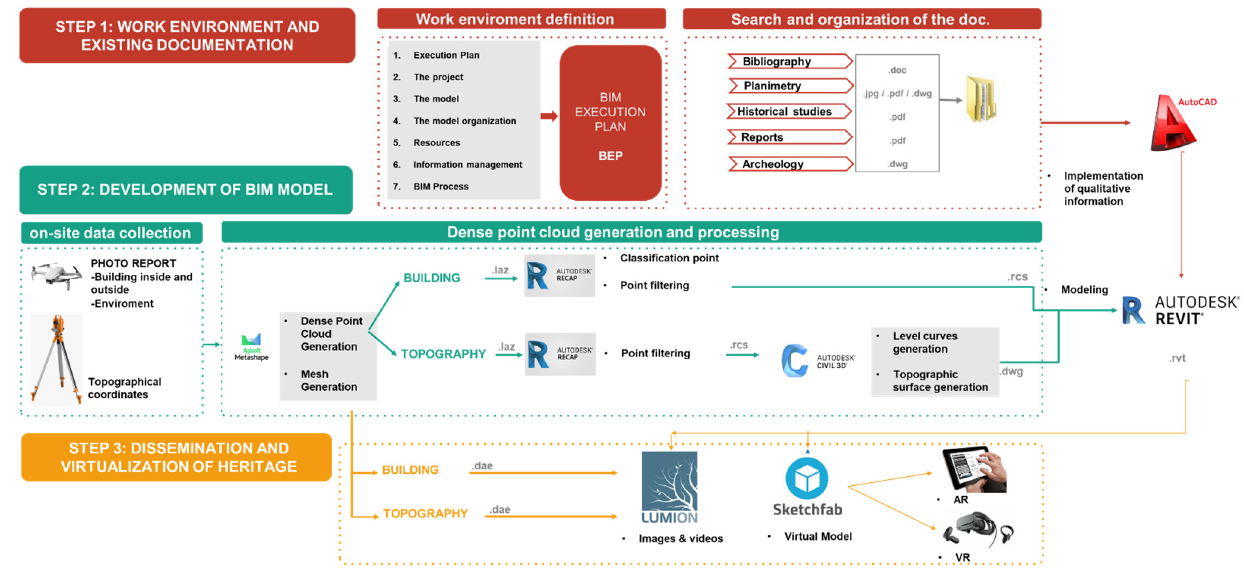
Figure 23. Scheme of the protocol and workflow from data capture to heritage dissemination.